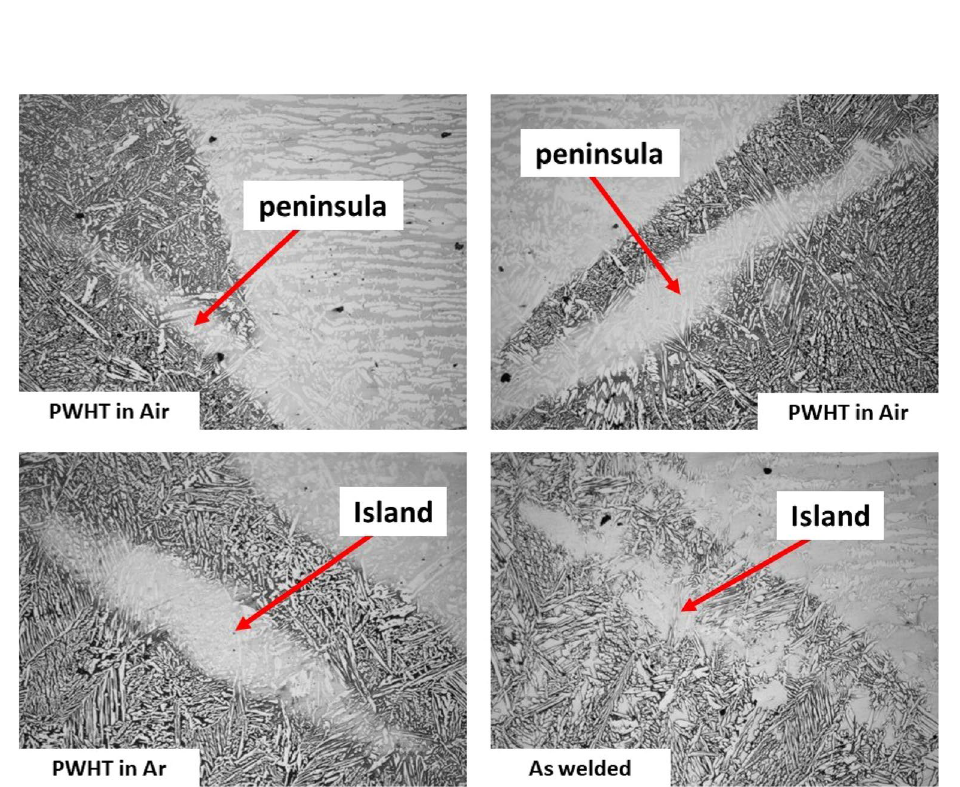
Figure 16. Fusion boundary (HAZ–WZ